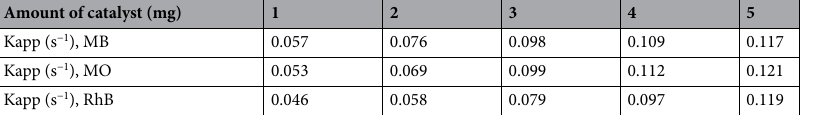
Amount of catalyst